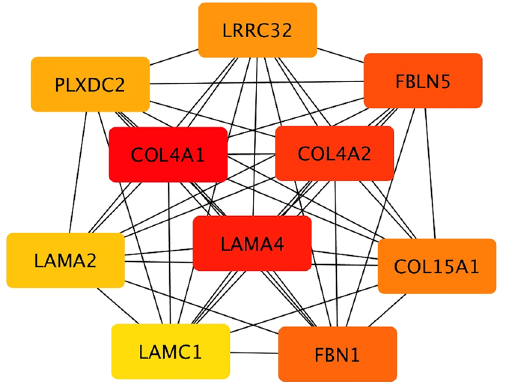
Figure 3. Top 10 hub genes in the macro-module identified by CytoHubba Cytoscape plugin. Genes with the highest number of connections in the network are detected as hub genes. The image shows the degree of importance of hubs through a color scale ranging from red (the most important) to yellow (less important).